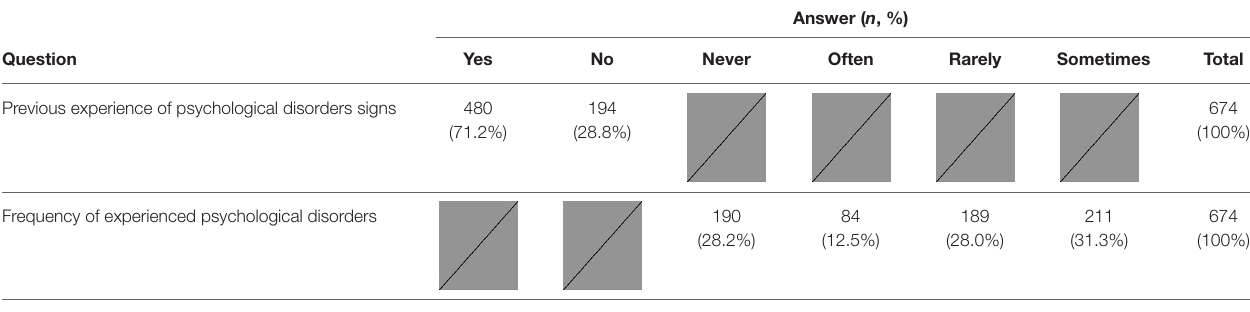
TABLE 2 | Participants’previous psychological disorder events and their